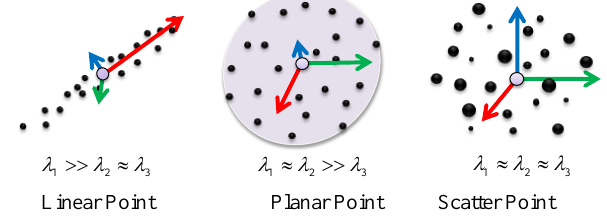
Figure 2. Point classification by